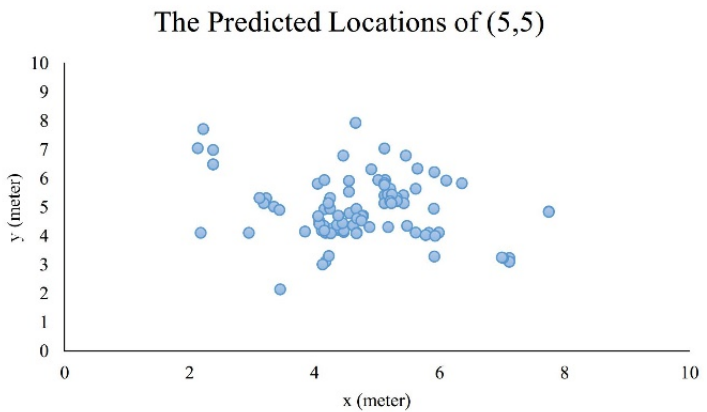
Figure 9. Perform location queries at a fixed point.